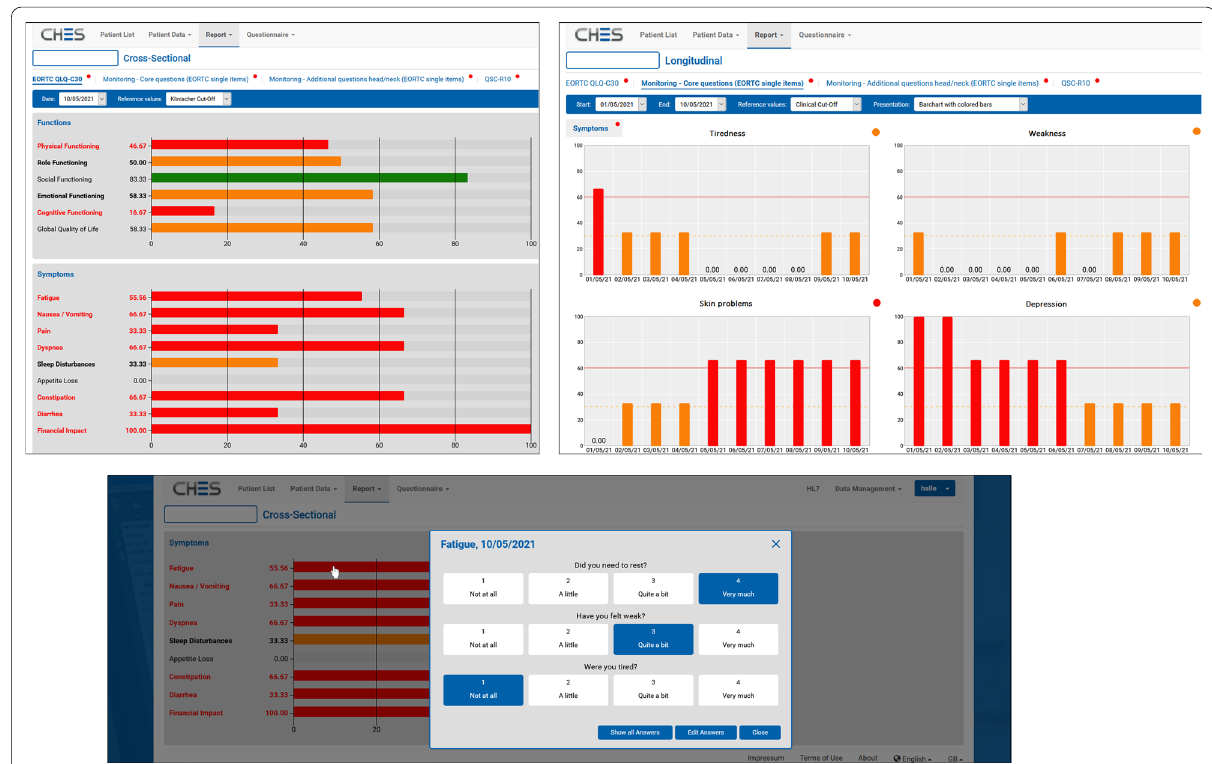
Fig. 2 Example for a cross‑sectional (top‑left) and longitudinal display (top‑right) of results including single questions